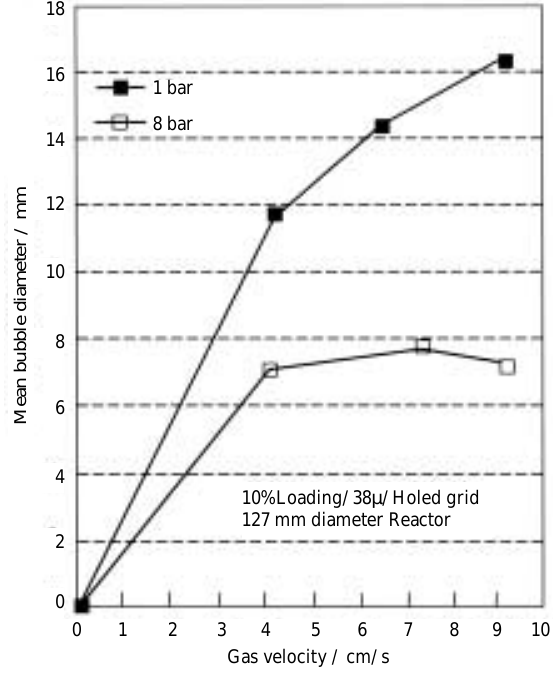
Fig. 12 Effect of gas velocity on bubble size